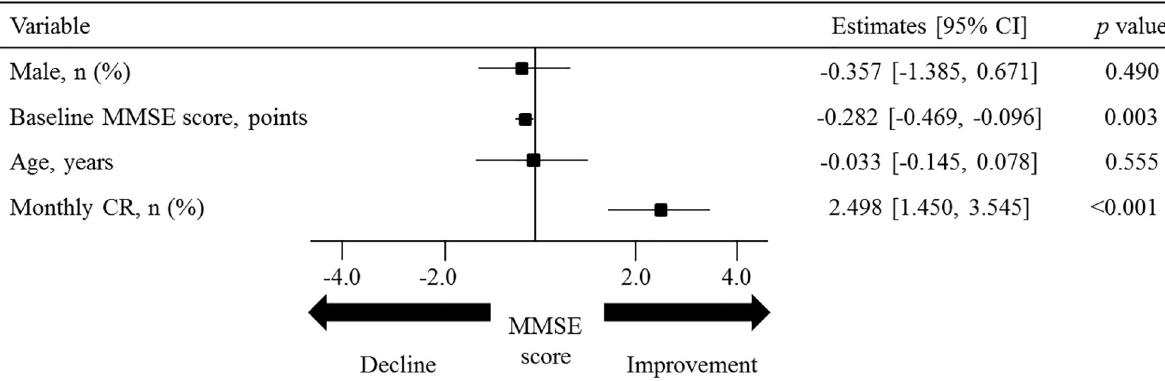
Fig 3. Clinical factors for the response of the MMSE score. General linear modeling analysis for the absolute change in the MMSE score shows that the baseline MMSE score and monthly CR are predictors of unfavorable and favorable response, respectively. CI, confidence interval; CR, cardiac rehabilitation; MMSE, Mini-mental State